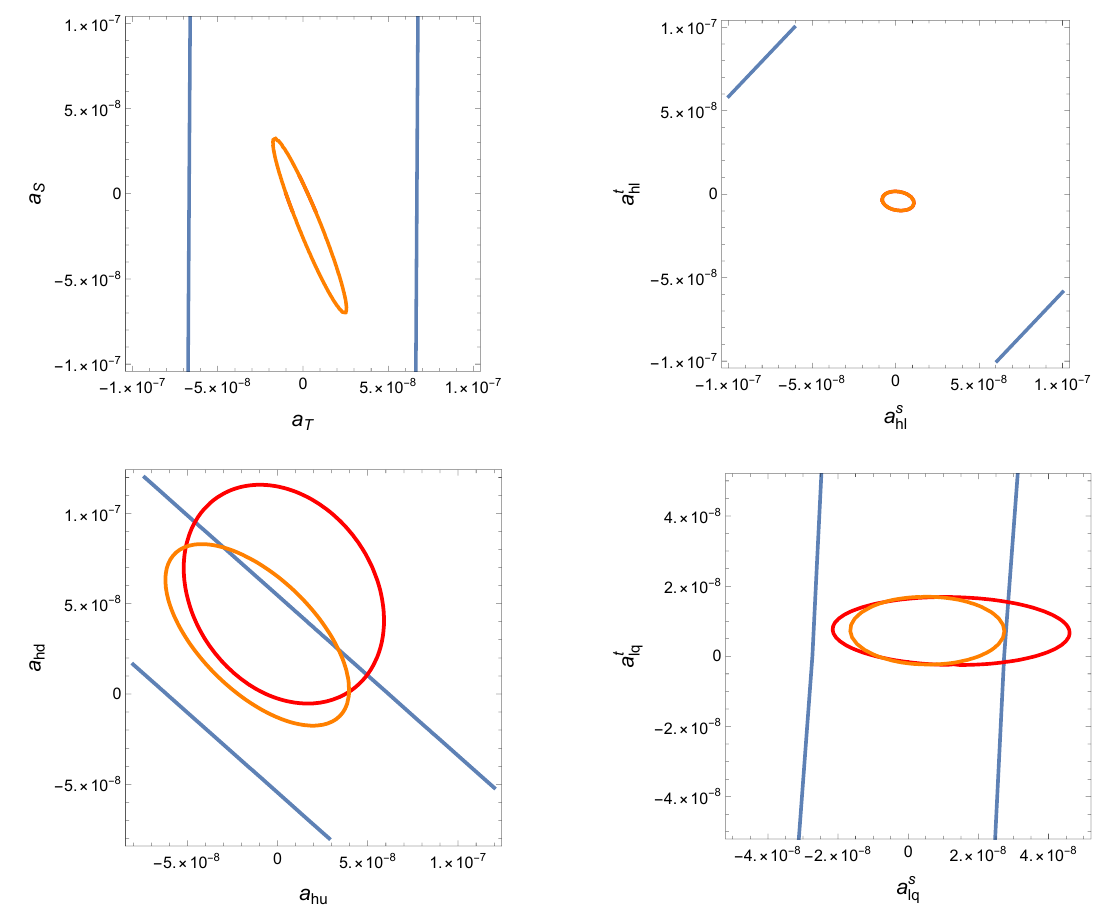
Figure 1 . Comparison between the bounds in [31] and future COHERENT bounds projected onto planes of two coefficients at 90% confidence levels. The COHERENT bounds are the nearly parallel lines in the plots (blue). The existing bounds are the larger ellipses (red) and the combined bounds are the inner ellipses (orange). For the plots in the top row the red and orange curves overlap showing that COHERENT will not improve bounds on the operators in those